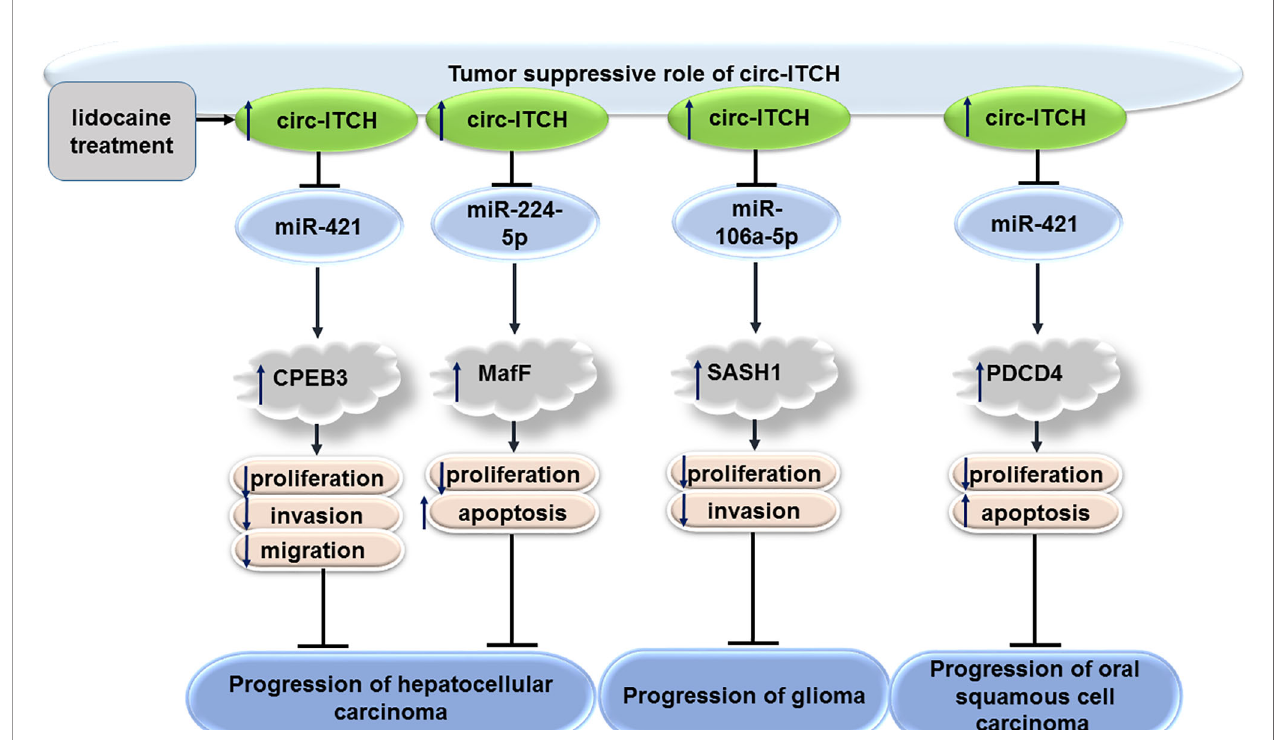
FIGURE 3 | Tumor suppressor role of circITCH in hepatocellular carcinoma, glioma and oral squamous cell